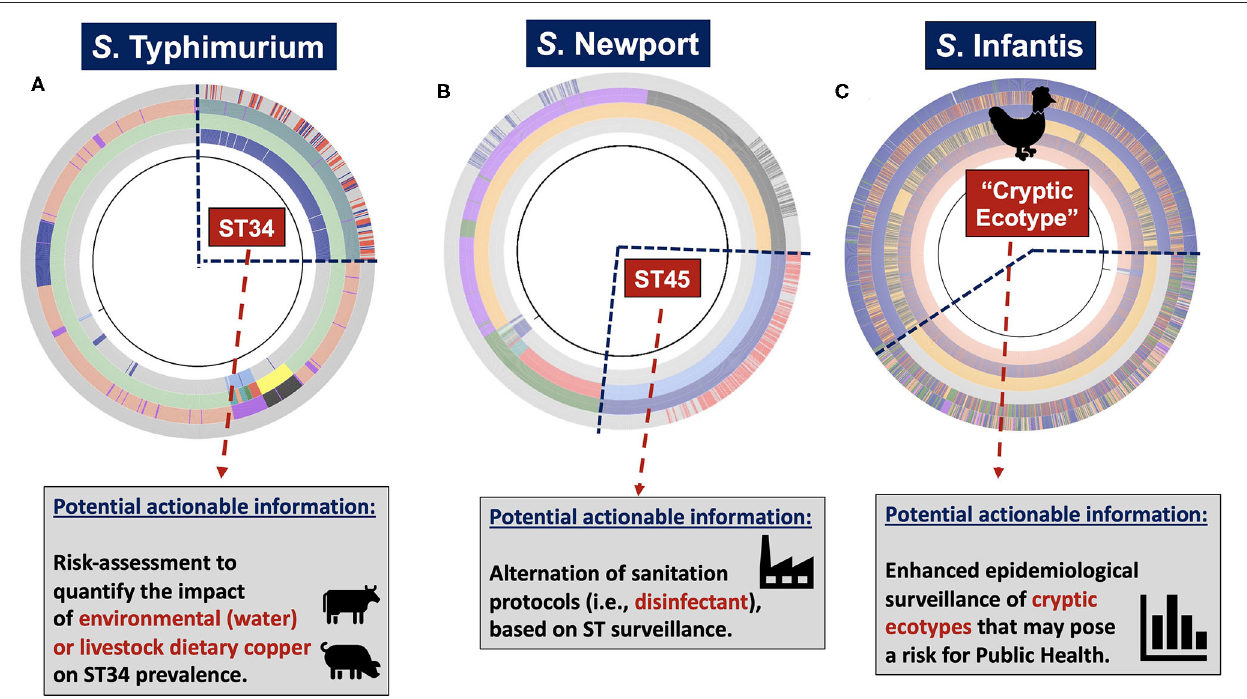
FIGURE 8 | Systems-based heuristic and hierarchical population structure mapping of pan-genomes can generate actionable information to improve food safety. (A) Loci-enrichment analysis, followed by phenotypic testing, confirmed that the S . Typhimurium ST34 (Monophasic) lineage has acquired and maintained the capacity to resist AMR such as heavy-metals (i.e., copper). This information ensues the need for a risk-assessment based analysis to understand the impact of environmental (e.g., water reservoirs) presence or dietary utilization of copper in livestock production systems, on the spread and persistence of ST34. (B) In the population of S . Newport, ST45 appears to be more capable of withstanding population bottlenecks generated by quaternary ammonium compounds (quats). If generalizable, this information suggests that ST-based surveillance of S . Newport would be an indicator for optimization of sanitation protocols in food facilities. In particular, disinfectants others than quats would be more efficacious in decreasing ST45 contamination. (C) Agnostic mining of the accessory genome revealed two cryptic Ecotypes in the population of S . Infantis. Specifically, Ecotype 1 appears to have emerged in poultry population, and yet retains the capacity to spill-over into humans. Importantly, these two cryptic sub-populations would not have been discovered using the canonical MLST-based genotypic analysis. Hence, the combination of an agnostic and heuristic mining of pan-genomic information has the potential to maximize epidemiological surveillance capabilities to pathogenic serovars that may pose a risk for Public